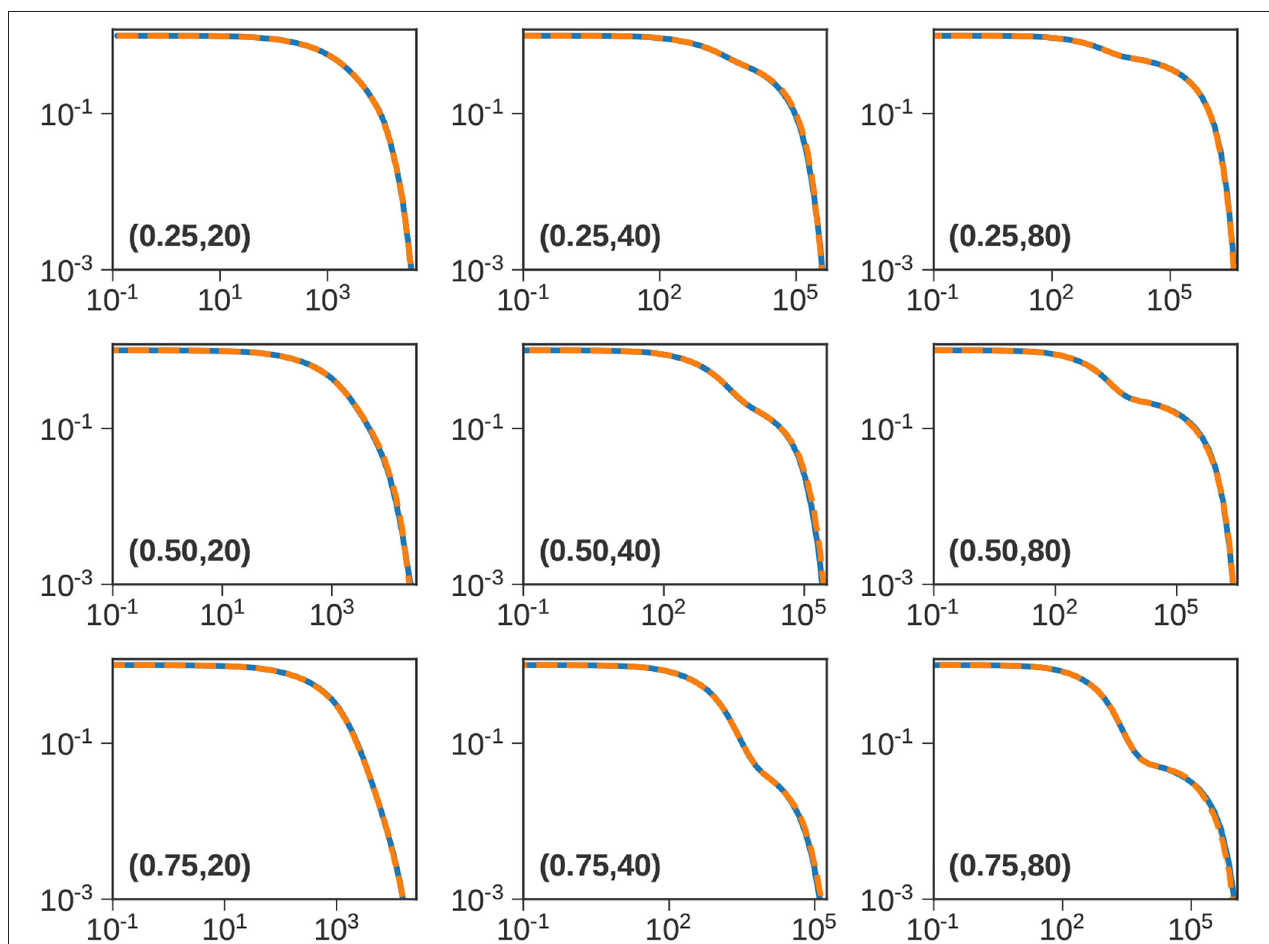
FIGURE 7 | Bidisperse blends. Normalized stress relaxation predictions [ φ ( t ) vs. t ] using the CTS (solid blue) and ATS (dashed orange) methods with ¯ Z 1 = 10. The composition ( w 1 ) and long chain length ( ¯ Z 2 ) are indicated in parenthesis. Note that the figure in the center corresponds to the base case studied in Figure 4B